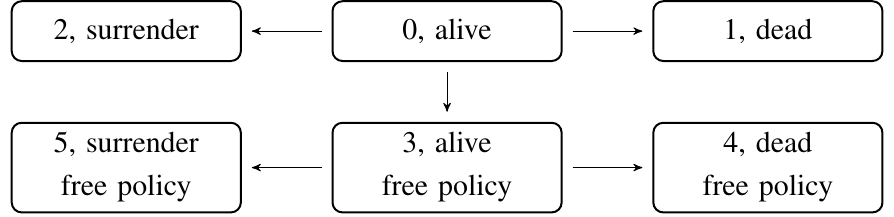
Figure 3. Survival Markov model with surrender and free